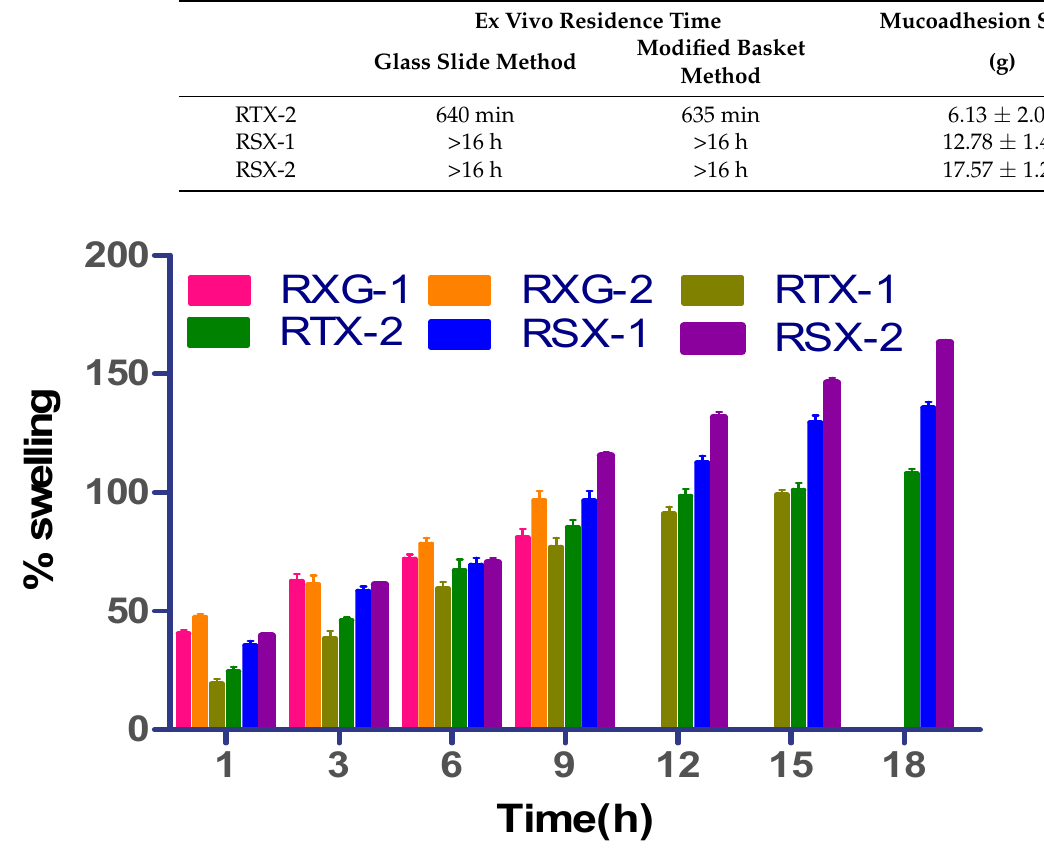
Figure 7. Swelling studies of repaglinide mucoadhesive formulations. Table 7. Comparison of ex vivo mucoadhesion time and mucoadhesion strength.